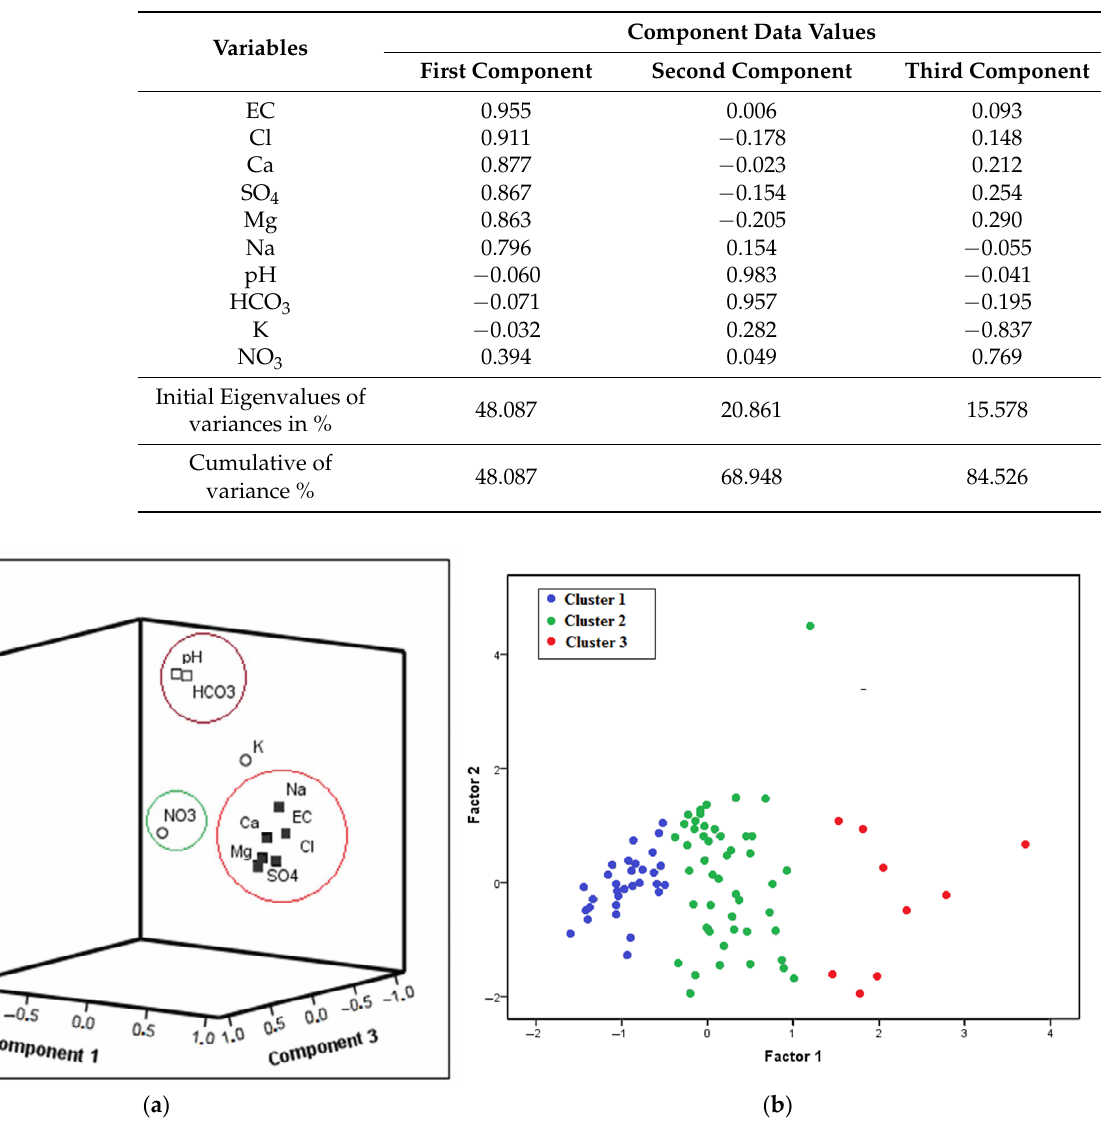
Figure 7. ( a ) 3D Variables projection on the factors plan (PC1 × PC2 × PC3); ( b ) Samples Projection plot on PC1 and PC2.